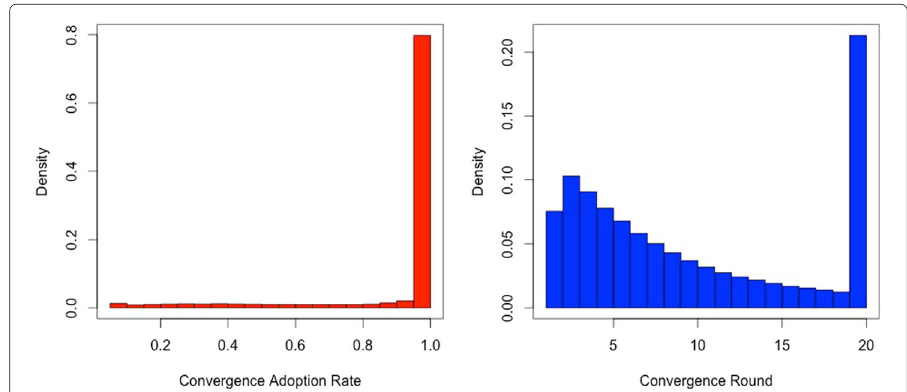
Fig. 4 Histograms of convergence adoption rates and convergence rounds (positive externality